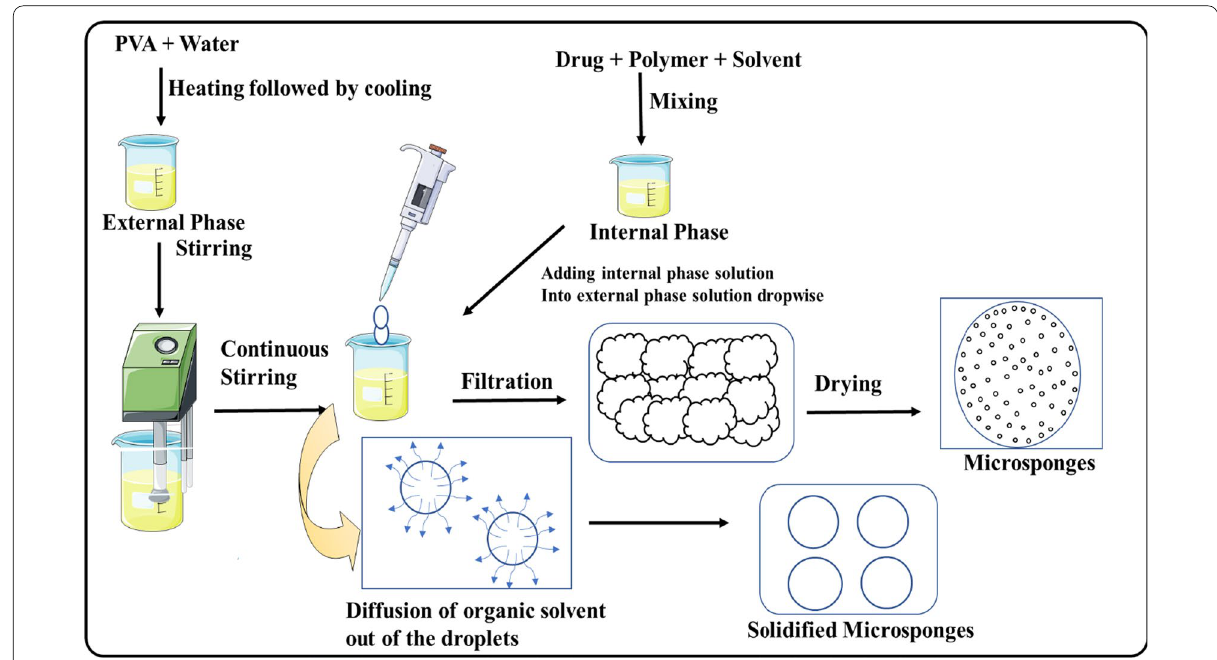
Fig. 7 Ultrasound-assisted microsponge